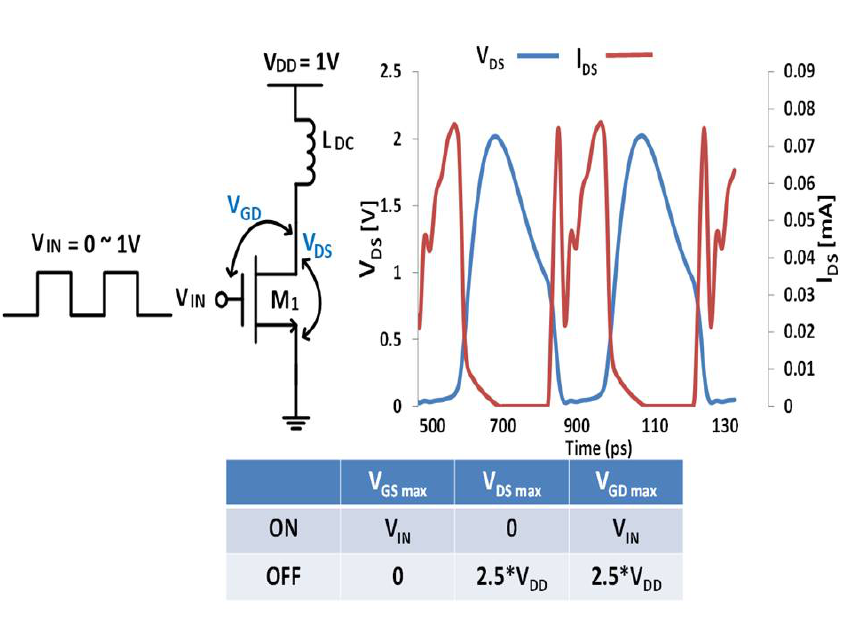
Figure 4. Maximum voltage stresses on transistor M1 in both on and off